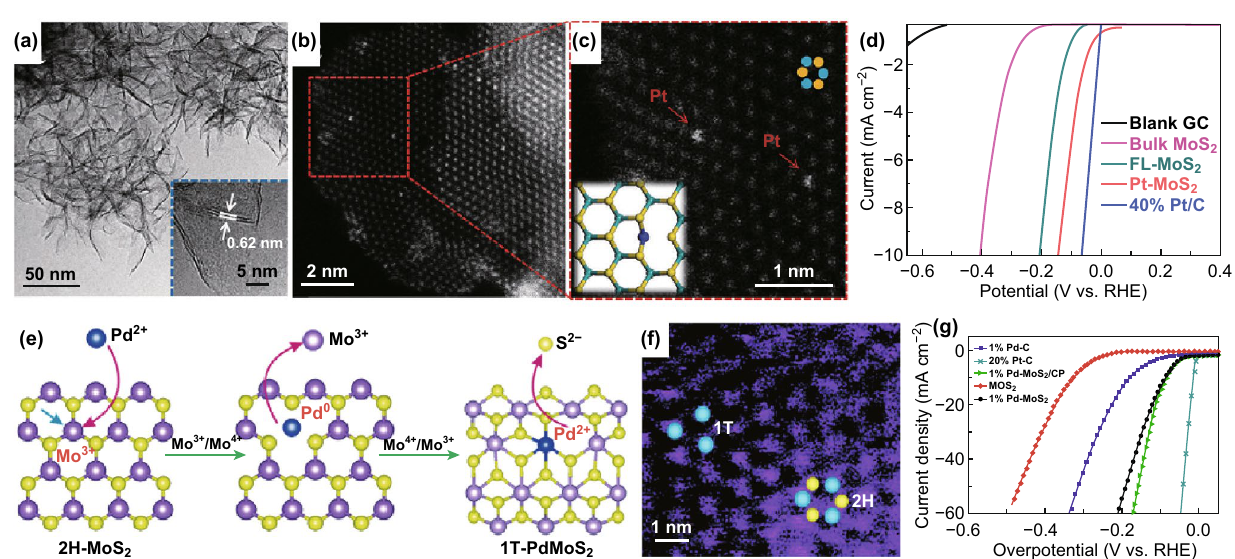
Fig. 13 a TEM and b HAADF-STEM images of Pt–MoS 2 . c Magnified domain with red dashed rectangle in b . d Polarization curves for bulk MoS 2 , FL–MoS 2 , Pt–MoS 2 , and 40% Pt/C. e Schematic illustration of the spontaneous MoS 2 /Pd (II) redox reaction. f Dark-field STEM image of the 1%